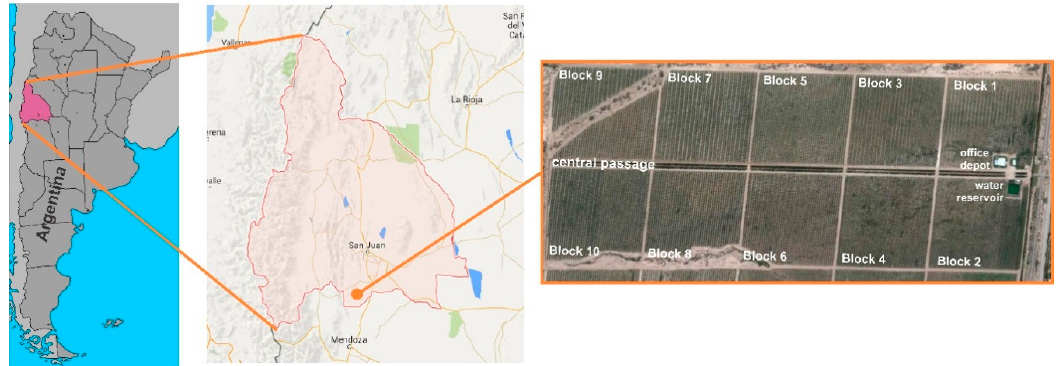
Figure 10. Location of the experimental olive orchard, in Cañada Honda, province San Juan.